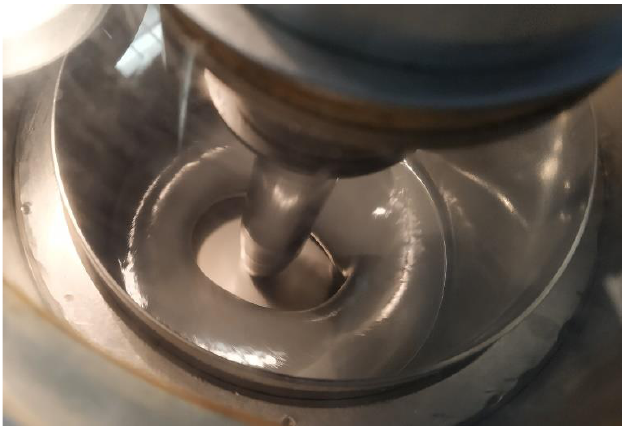
Figure 2. Mixing of nanomaterials in resin at 5800 rpm.